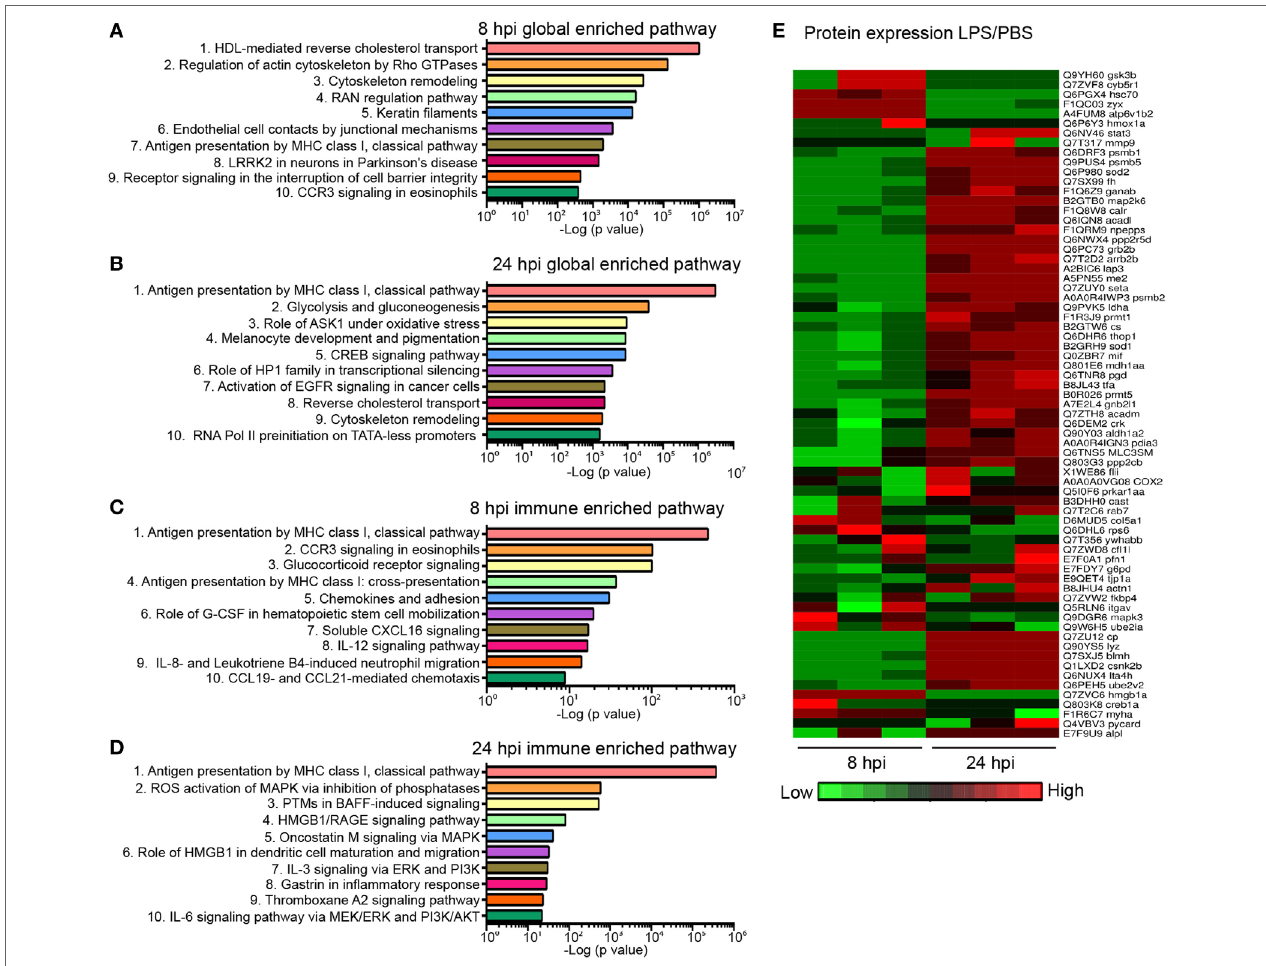
FigUre 6 | Global proteomics analysis in the zebra fish endotoxemia model. Three days post fertilization larvae were either injected with PBS or lipopolysaccharide (LPS). Samples were flash-frozen at 8 and 24 hours post injection (hpi) and subjected to proteomics analysis. Proteins with significant difference in expression levels were then subjected to pathway analysis. (a,B) Top 10 global-enriched pathways at 8 (a) and 24 hpi (B) in LPS-injected larvae compared to that of PBS-injected control. (c,D) Top 10 immune pathways enriched at 8 (c) and 24 hpi (D) LPS-injected larvae compared to that of PBS-injected control. The − log 10 p -values below the graph were calculated by MetaCore software and indicate the magnitude of alteration of the whole network ( n = 3 independent experiments with over 20 larvae each/experiment). (e) Fold changes of proteins involved in the top 10 enriched immune pathways at 8 and 24 hpi. The heat map presents the relative expression of proteins in LPS-injected larvae compared to that of PBS-injected control. Three independent experiments are